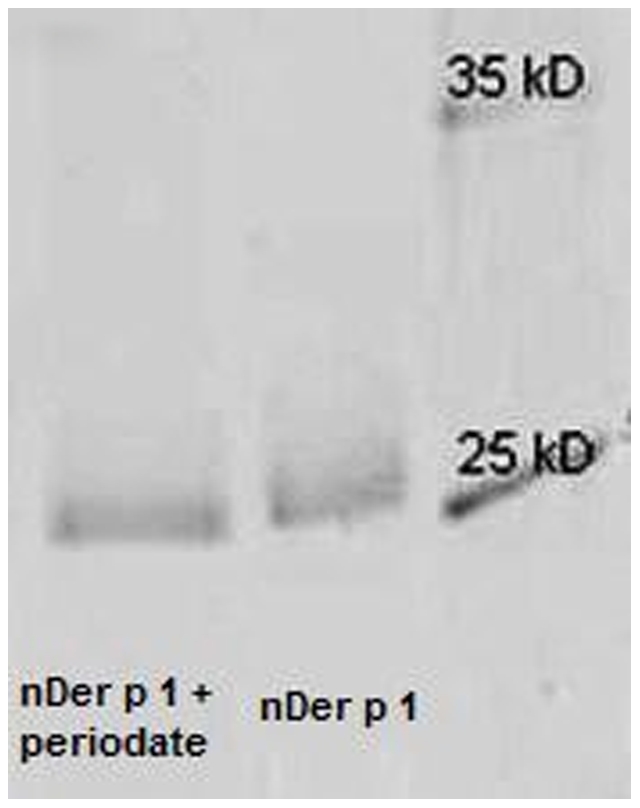
Commassie blue stained gel of natural Der p 1 before and after deglycosylation with periodate showing a slight decrease in the MW of deglycosylated Der p 1.